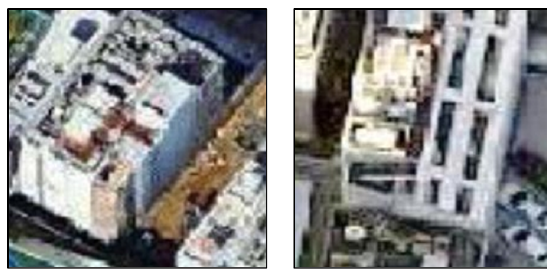
Figure 11 . Example of detached house images estimated as detached houses